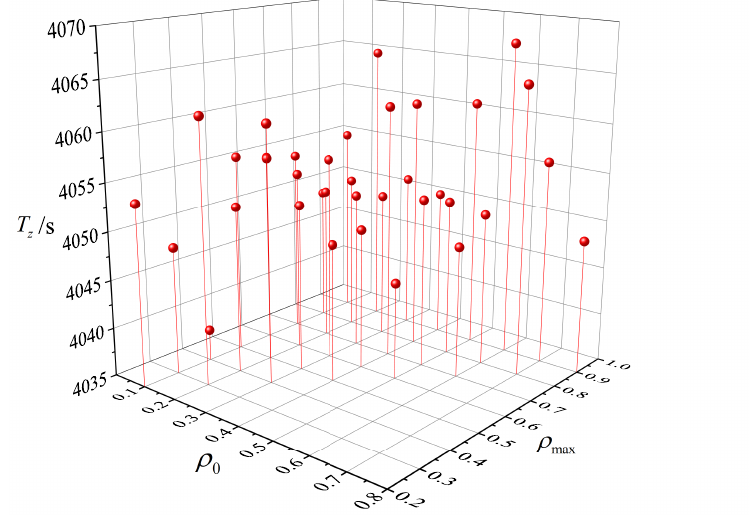
Figure 16. Variation curve of total time T z with pheromone volatilization loss